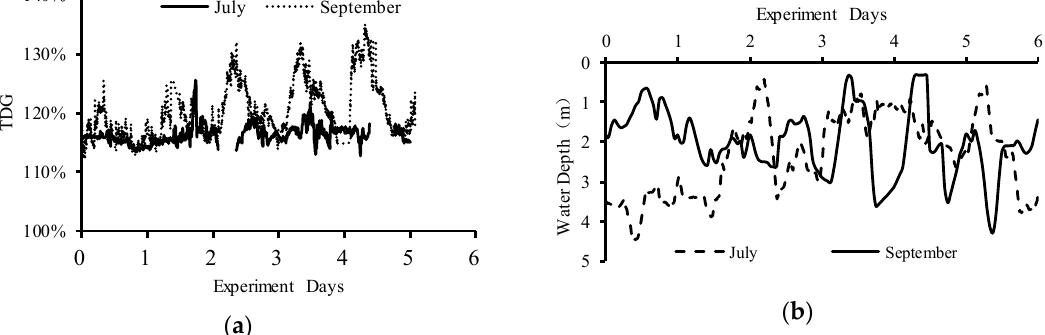
Figure 4. TDG supersaturation level ( a ) and water depth ( b ) at the experimental site. TDG data are missing in two periods in July due to powering off the Point Four Tracker.